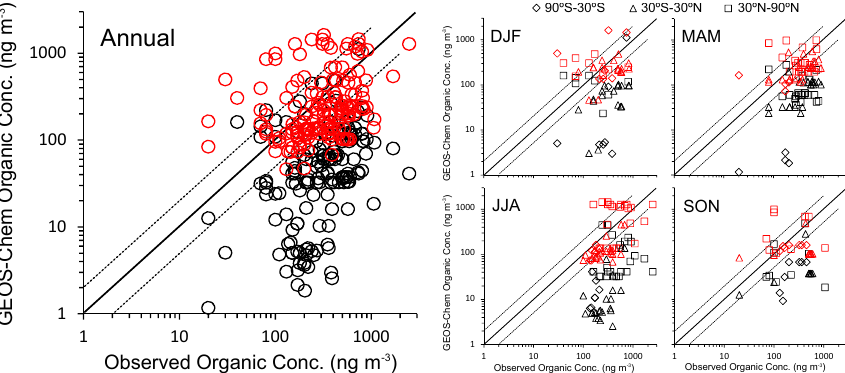
Figure 3. Global comparison of observed clean marine organic aerosol concentrations compiled by Gantt and Meskhidze (2013) and GEOS- Chem-predicted terrestrial (black) and total (marine + terrestrial, in red) submicron organic aerosol concentrations. The solid and dotted lines represent the 1 : 1 line, 1 : 2 and 2 : 1 lines, respectively.